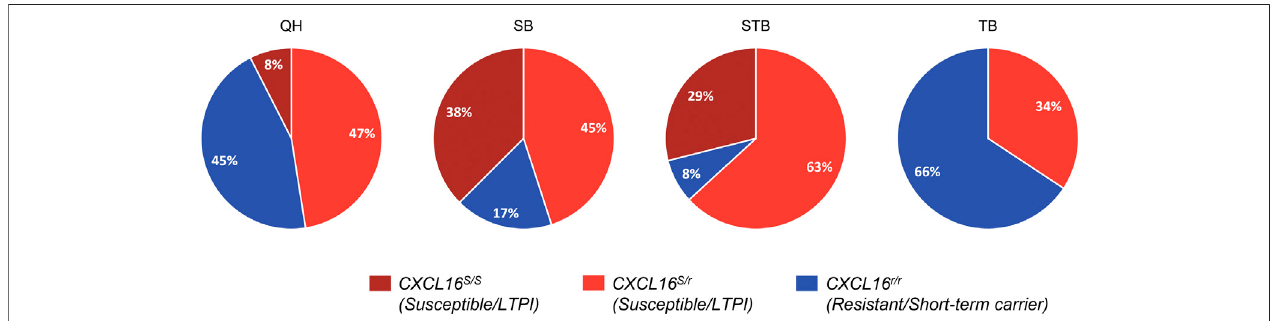
FIGURE 4 | CXCL16 genotype distribution among diverse horse breeds. Distribution of the three different CXCL16 genotypes among different horse breeds included in the study ( n = 40 for each breed). Dark red: CXCL16 S/S ; light red: CXCL16 S /r ; blue: CXCL16 r / r . LTPI: Long-term persistent infection.